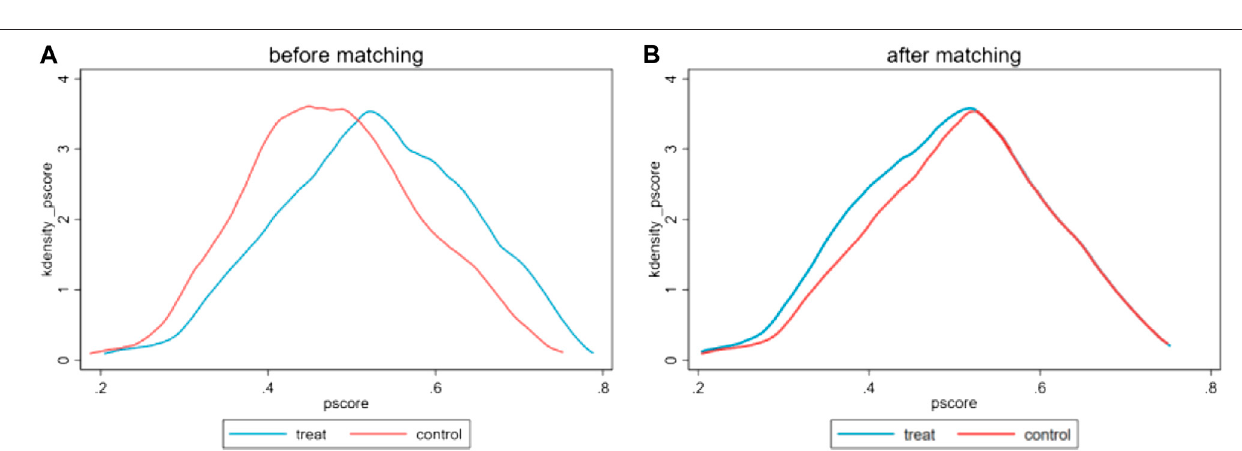
FIGURE 5 | Kernel density estimate of smart meters. (A) Before matching; (B) After